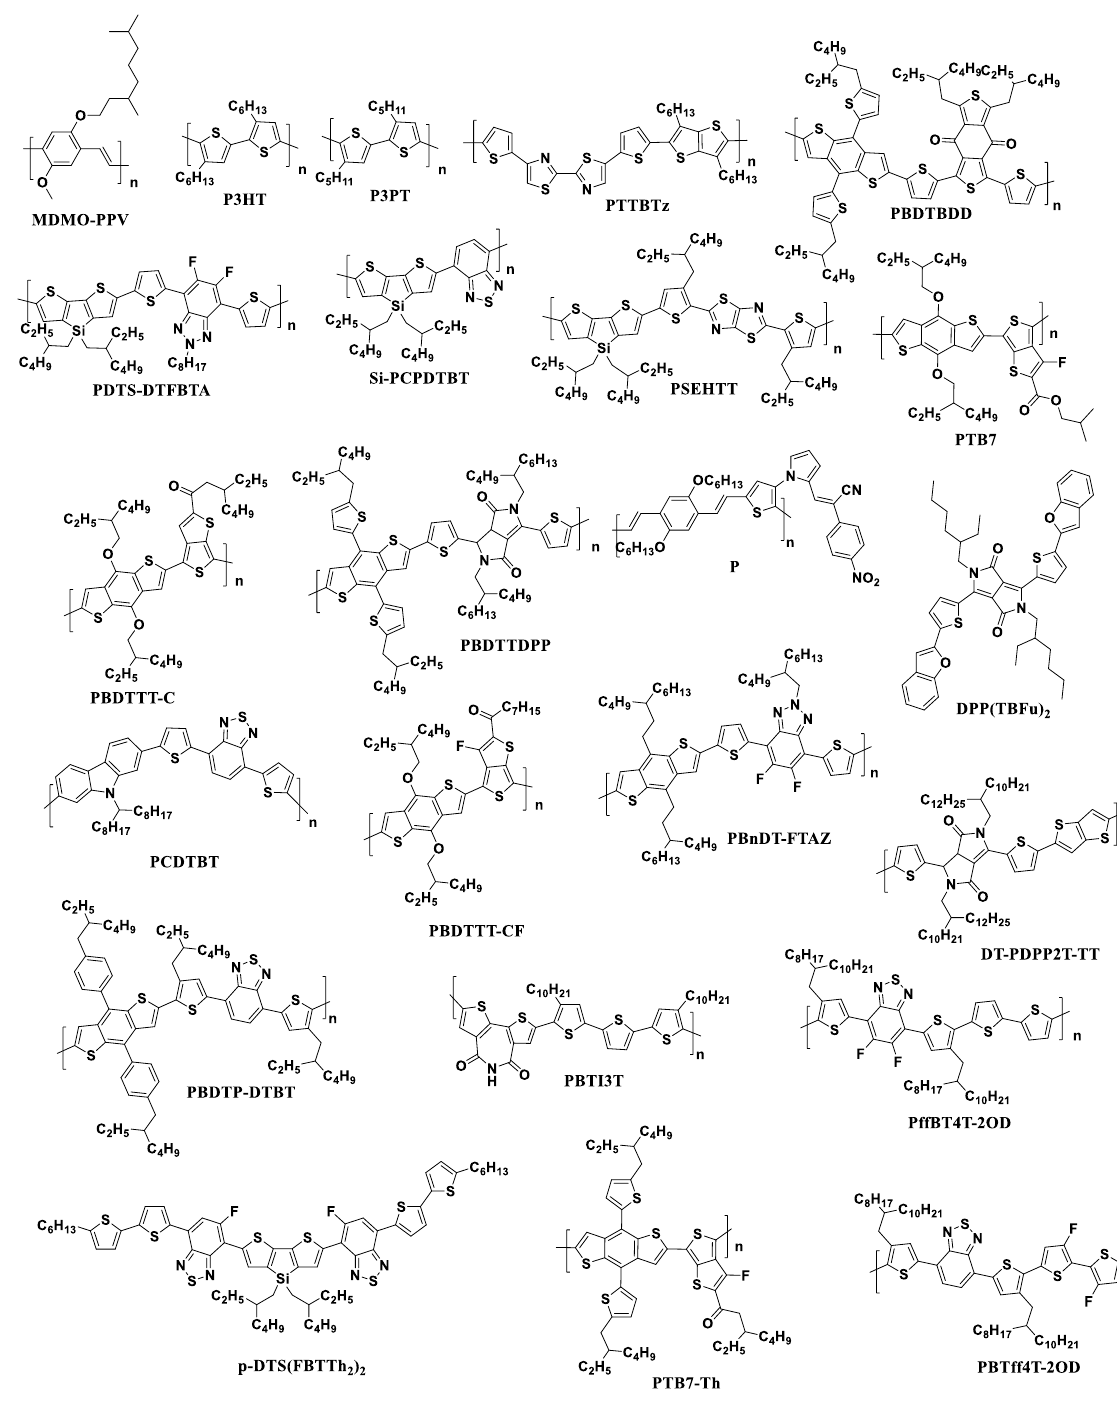
Figure 9. Molecular structures of electron donor materials used in combination with the fullerene derivatives with reduced electron affinity.